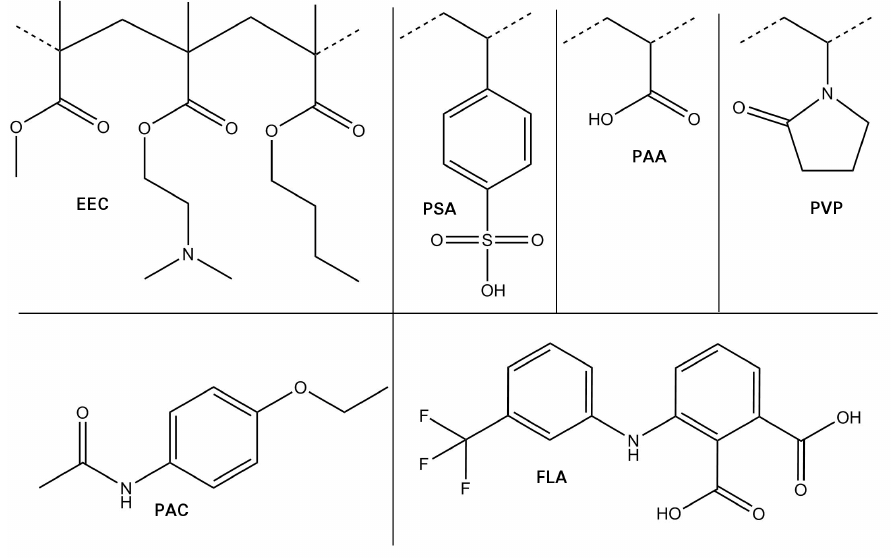
Figure 2. Compounds used in this study: ( top ) Polymers: eudragit (EEC), polystyrene sulfonic acid (PSA), poly acrylic acid (PAA), and poly vinylpyrrolidone (PVP); and ( bottom ) APIs: phenacetin (PAC) and flufenamic acid